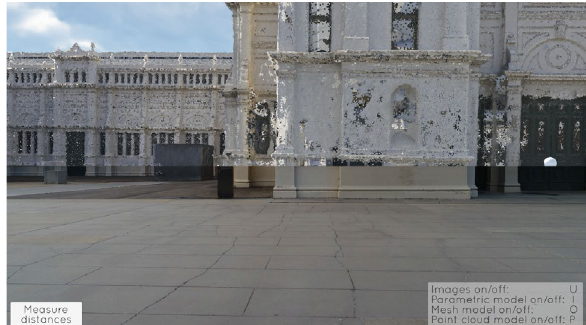
Figure 5. The integration of an image with a point cloud. Only the bottom half of the image is shown to better illustrate the integration and the 3D space behind